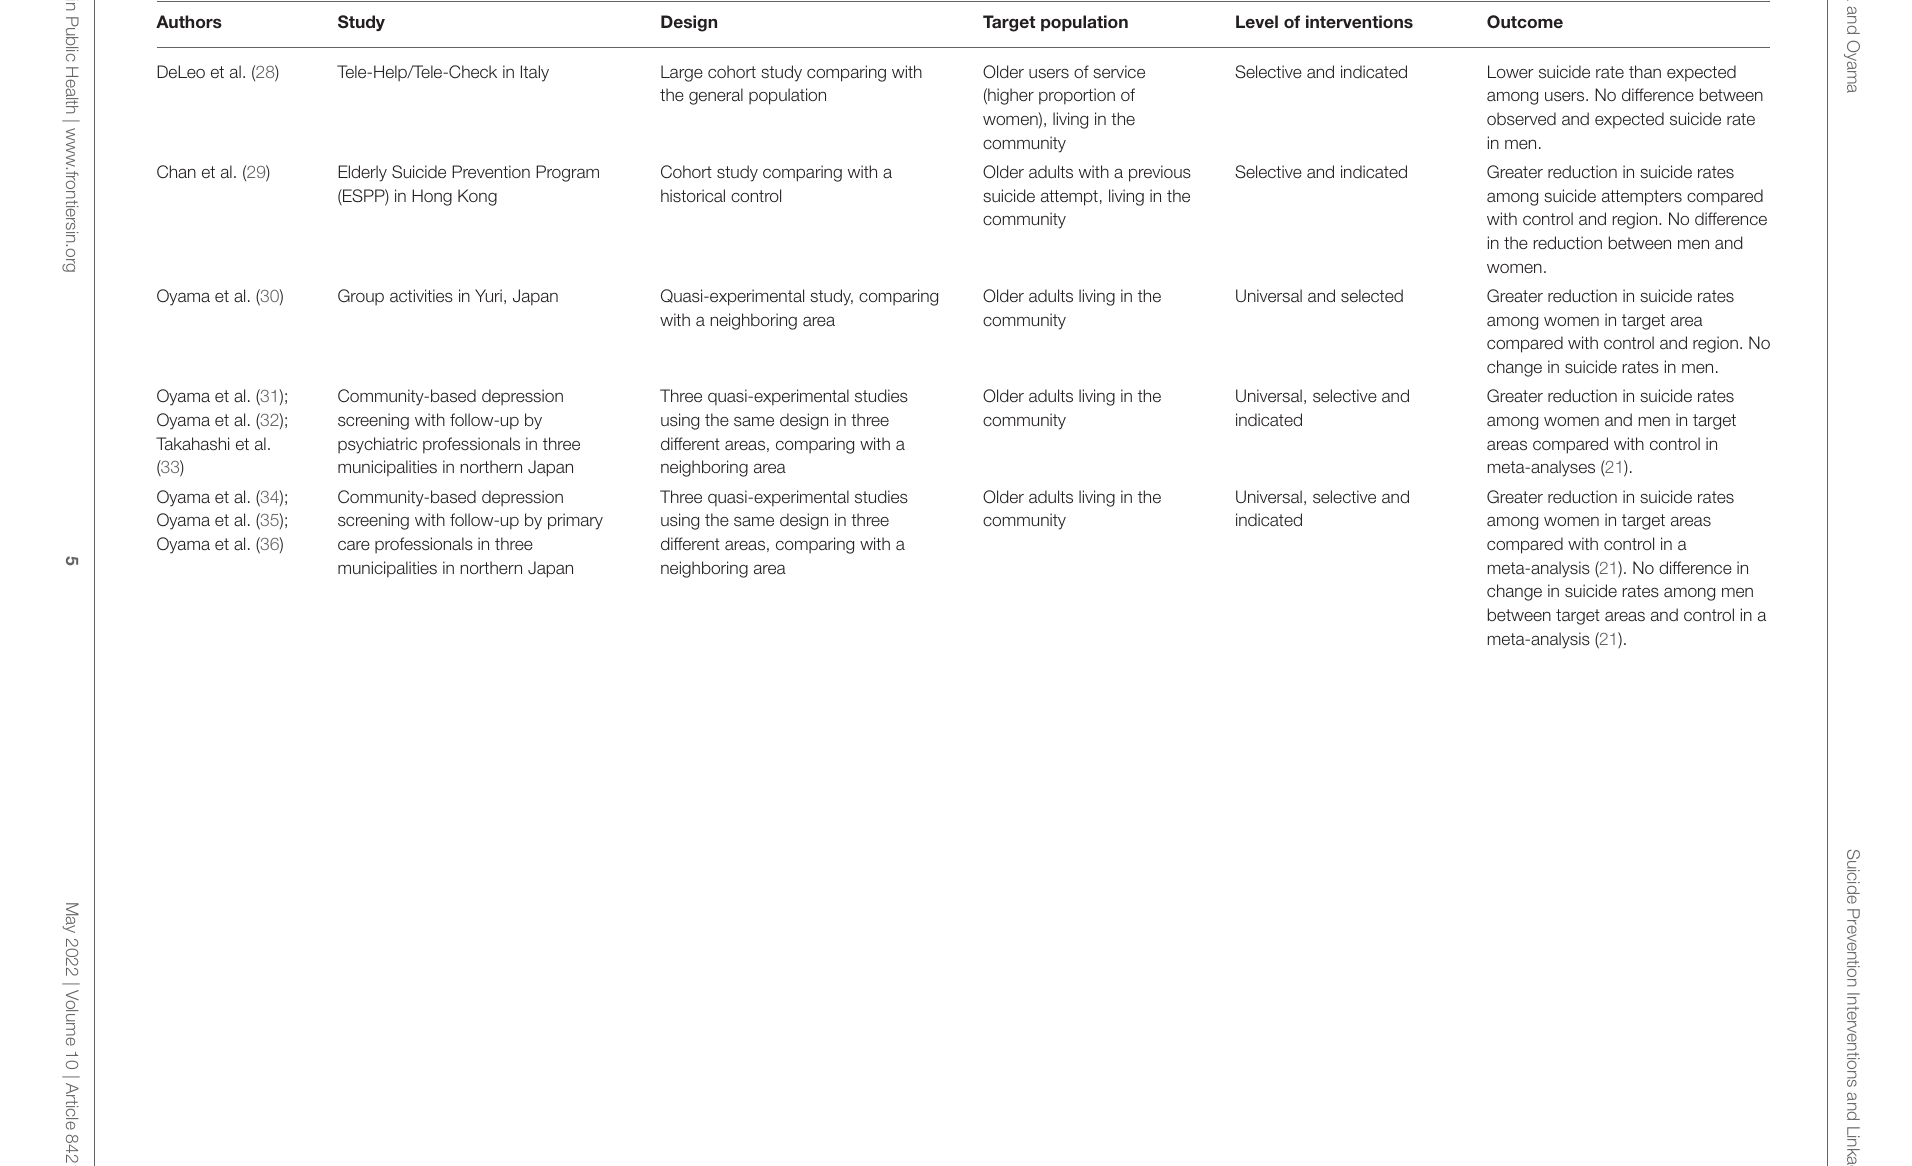
TABLE 1 | Studies included in the